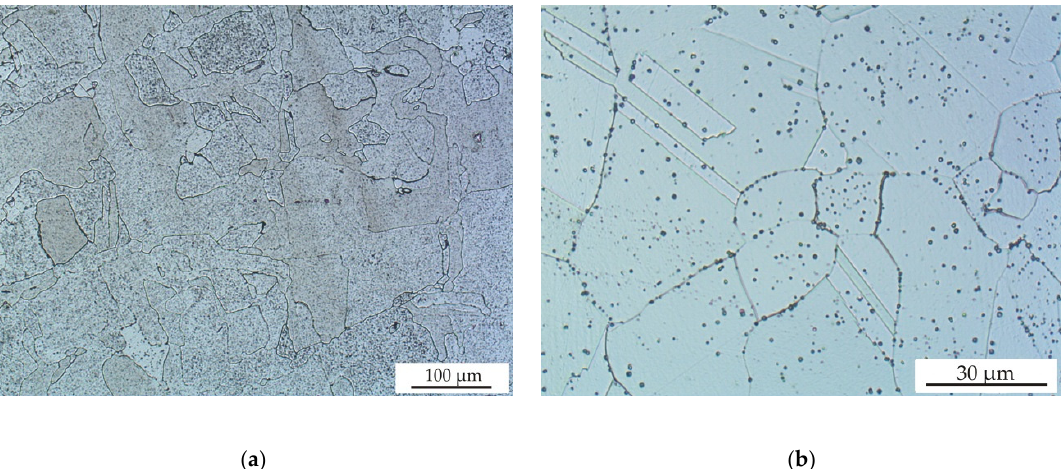
Figure 12. ( a ) OM image of sample 13 after HIP_1 treatment and ( b ) OM image of sample 2 after HIP_1 treatment, etched with Carpenter reagent.